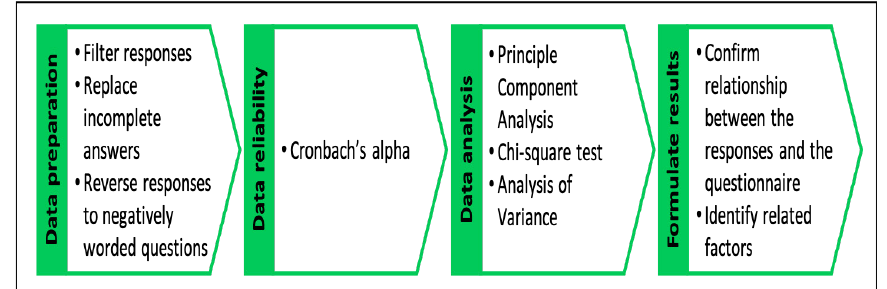
Figure 8: Data analysis